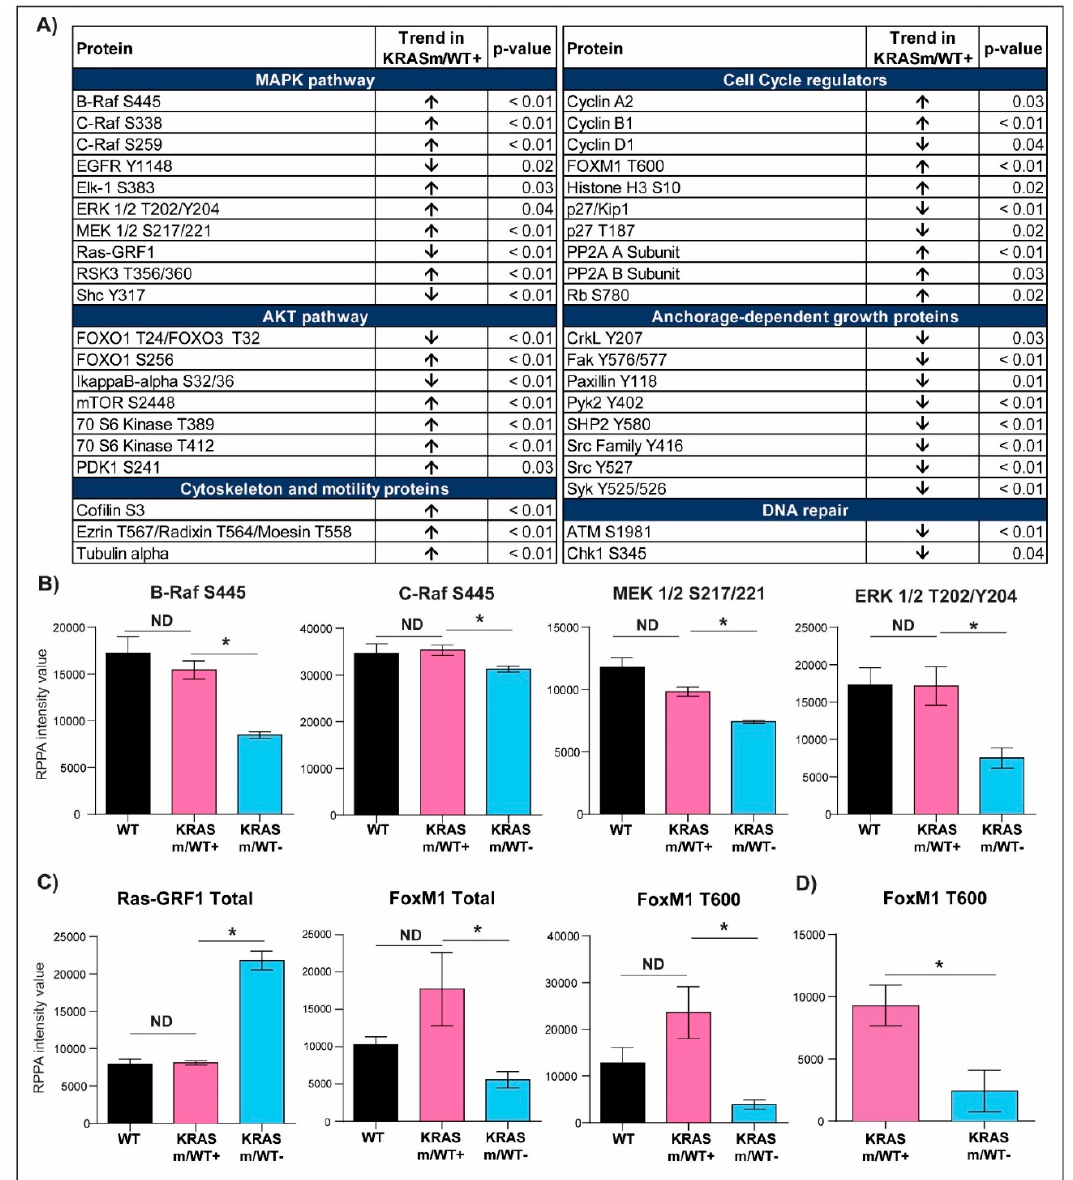
Figure 4. Selected signal transduction molecules differentially activated in KRASm/WT+ and KRASm/WT − NSCLC models. Of the 183 signaling molecules measured by RPPA, 81 reached statistical significance when KRASm/WT − and KRASm/WT+ cell lines were compared. Proteins belonging to the same signaling pathway were grouped based on their biological function and are displayed in ( A ). Arrows reflect trends in the KRASm/WT+ cells (H1734, H23, H358) compared to KRASm/WT − (A549, H2122) models. Bar graphs displaying mean and standard error of the mean for member of the MAPK pathway are shown in ( B ). Of interest, while the activation of KRAS downstream signaling substrates reached statistical significance when KRASm/WT − and KRASm/WT+ cell lines were compared (*), these differences were lost between KRASm/WT+ and KRAS wild-type models (ND). Similar trends were also detected for Ras-GRF1, a modulator of RAS activity, and the cell cycle regulator FoxM1 ( C ). Differences in the activation of the cell cycle regulator FoxM1 between KRASm/WT − and KRASm/WT+ tumors were confirmed in surgical specimens, suggesting clinical relevance for this finding ( D ). * Indicates comparisons that were statistically different ( p < 0.05).